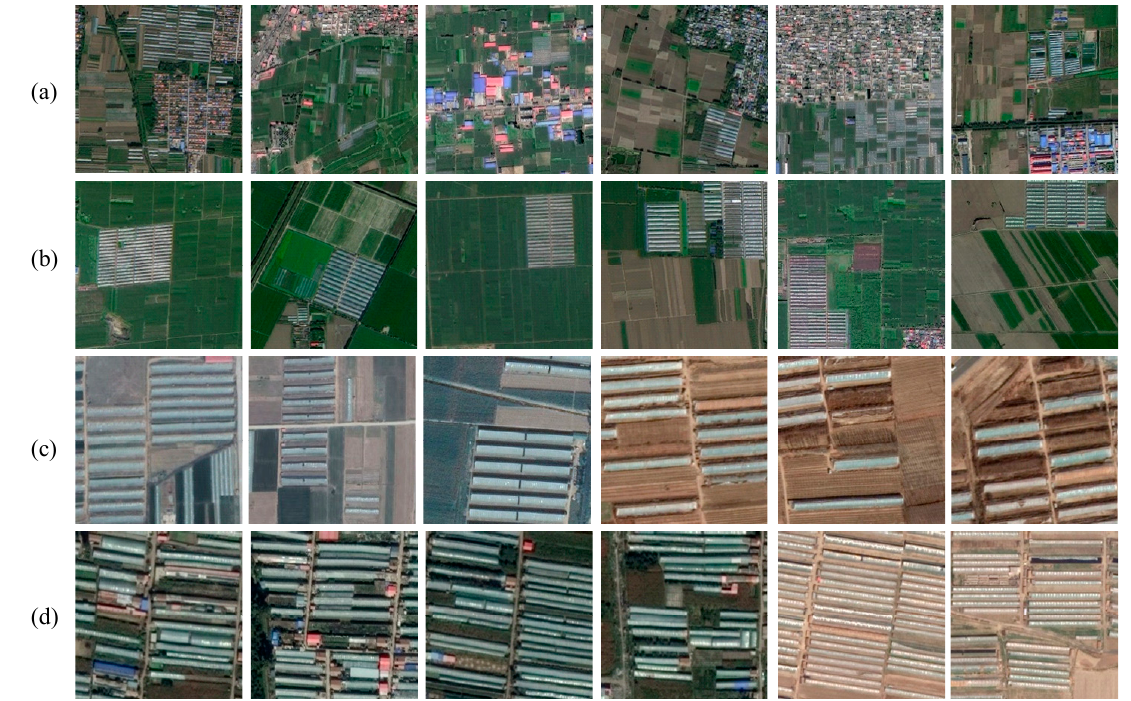
Figure 1. Examples of image tiles from the regions of interest (ROIs): ( a ) scatted agricultural greenhouses (AGs) surrounded by complicated backgrounds in GF-1 images; ( b ) regular AGs surrounded by apparent backgrounds in GF-1 images; ( c ) individual AGs surrounded by simple backgrounds in Gaofen-2 (GF-2) images; ( d ) fragmented and serried AGs in GF-2 image. Table 1. The dataset of